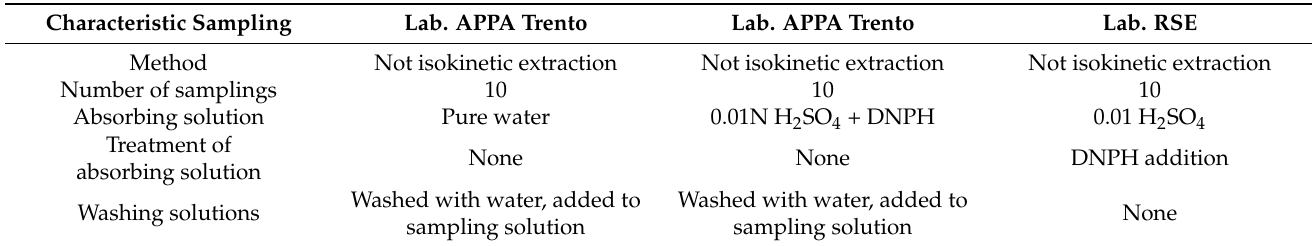
Table 4. Characteristics of the sampling method during the Second